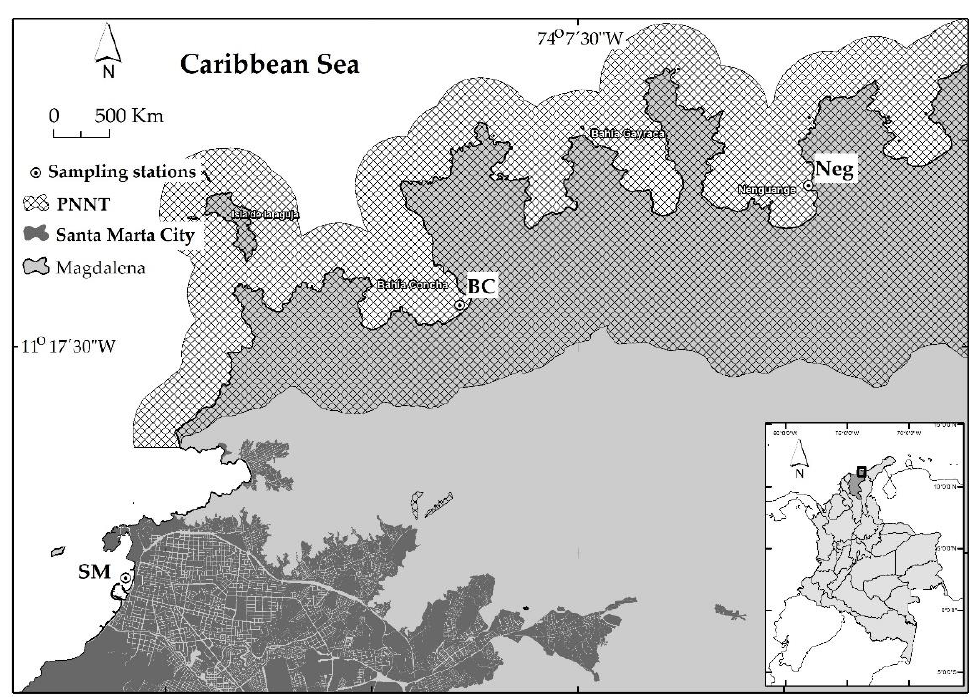
Figure 1. Location of sampling stations in Santa Marta Bay (BSM) and Tayrona National Natural Park (PNNT). SM: International Santa Marta Marina; BC: Concha Bay; Neg: Nenguange.